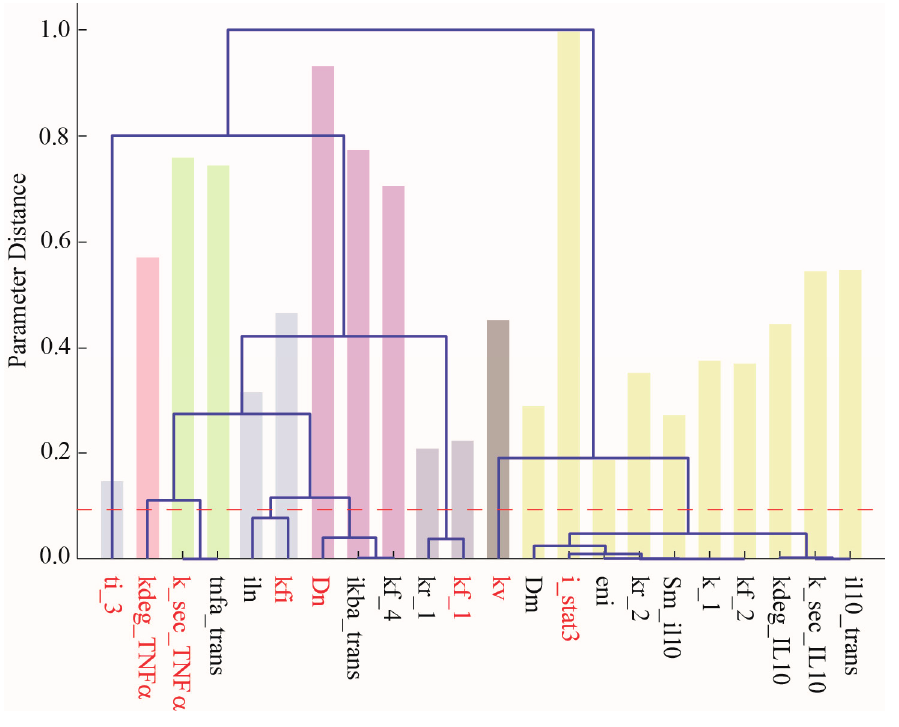
Figure 4. Representation of local sensitivity analysis results, used for selecting parameters that are to be estimated. The y -axis represents parameter distance ranging from zero to one. The red line represents the cutoff value, which groups the entire set of parameters into eight pairwise indistinguishable clusters. The selected parameters from each of the eight clusters are highlighted in red. The normalized sensitivity magnitudes of the parameters are reflected in the